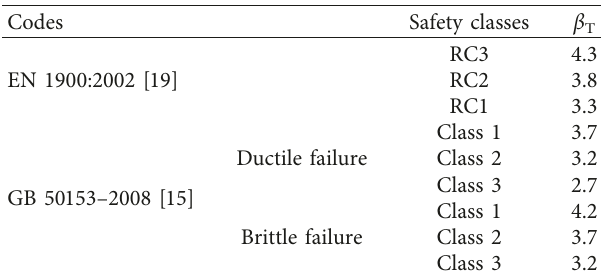
Table 12: Target reliability indices stipulated in EN 1900:2002 and GB 50153–2008 (ultimate limit state, 50 year reference